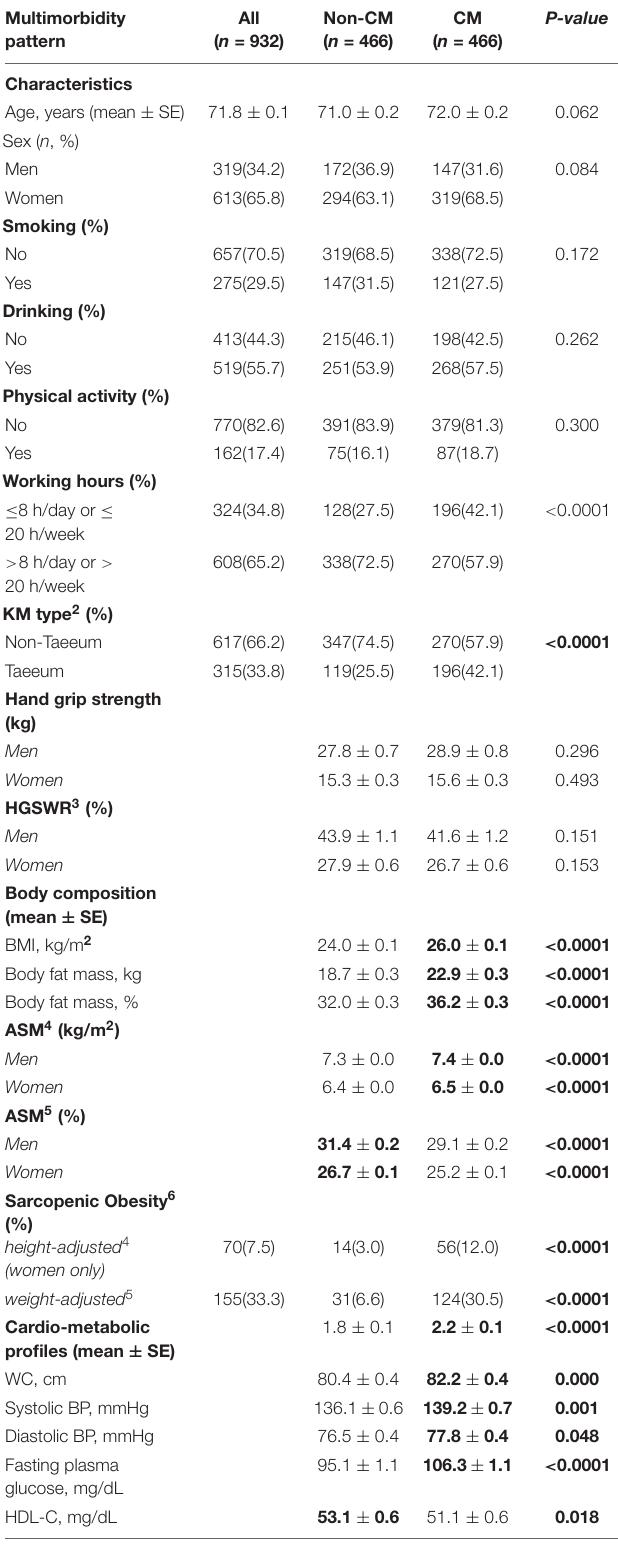
TABLE 1 | General characteristics, handgrip strength, body composition and cardiometabolic profiles of the participants according to their CM pattern 1 . Multimorbidity